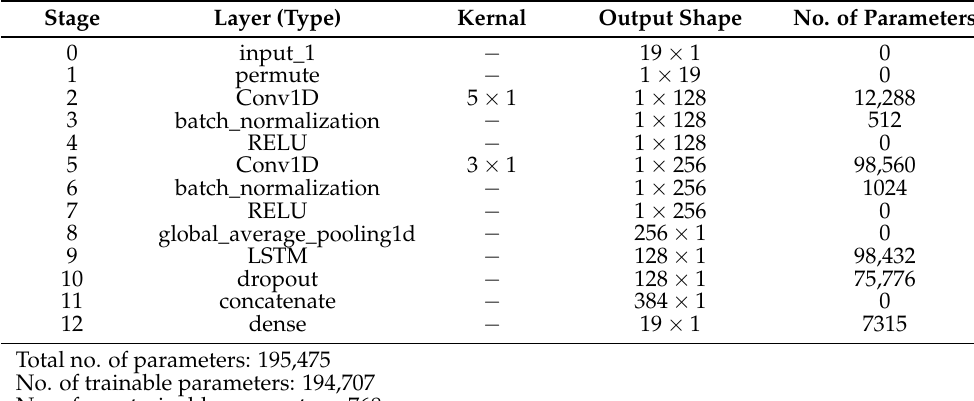
Table 1. Multivariate-based multi-label locational detection (MMLD) network for the IEEE 14-bus power